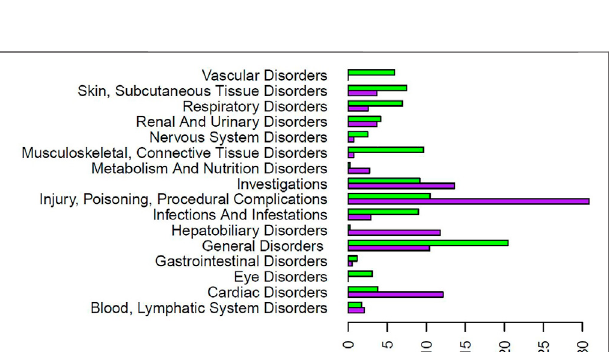
FIGURE 4 | Signi fi cant AE reaction group percentage comparison for COVID-19andSLEpatientstreatedwithHCQfromtheFAERSdatabase.The purpose bars represent the percentage of the total signi fi cant count for COVID-19 for each reaction group. The green bars represent the percentage of the total signi fi cant count for SLE for each reaction group. The reaction groups of Ear and Labyrinth Disorders, Immune System Disorders, Pregnancy, Puerperium and Perinatal Conditions, Product Issues, Psychiatric Disorders, Social Circumstances, and Surgical and Medical Procedures were left off the graph due to small percentages for both patient types. Note that only the AEs that have passed the signi fi cance test were used here for all calculations).HCQ AEpatterns appeared differentdepending onthediseases